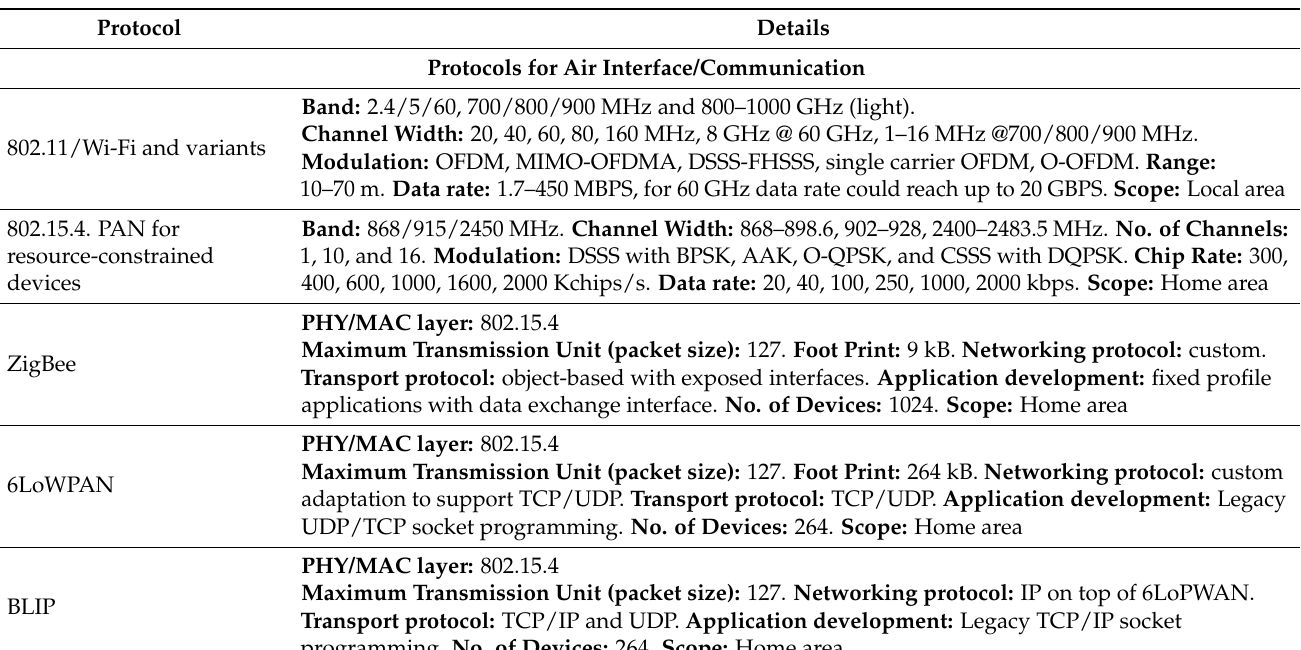
Table 8. Protocols for IoT and smart meters. Air interface protocols are defined by bandwidth, band, modulation and some medium access, whereas data communication protocols are defined by how they distribute data (architecture) and the support of different communication functionalities such as transport protocol, etc. Details Protocols for Air